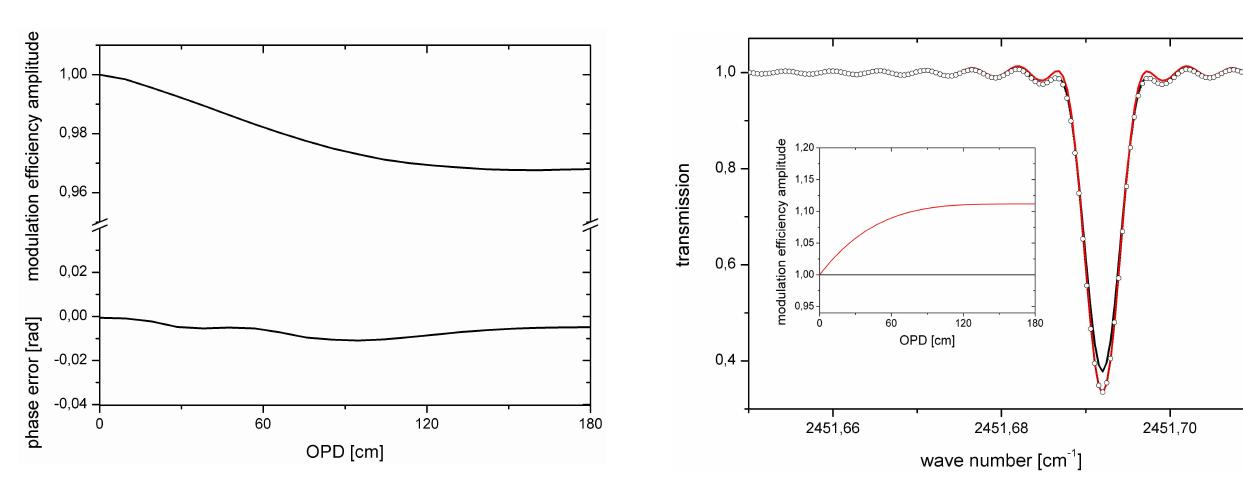
Fig. 4. The changes in an HBr absorption line which result from a 10% over-modulation. This example strongly exaggerates the ef- fect of a poor ZPD alignment. The black curve is the simulation with a nominal ILS, the red curve refers to the over-modulation, the open circles show a spectrum calculated with nominal ILS, but increasing the gas column by 12%. The inserted panel shows the assumed modulation